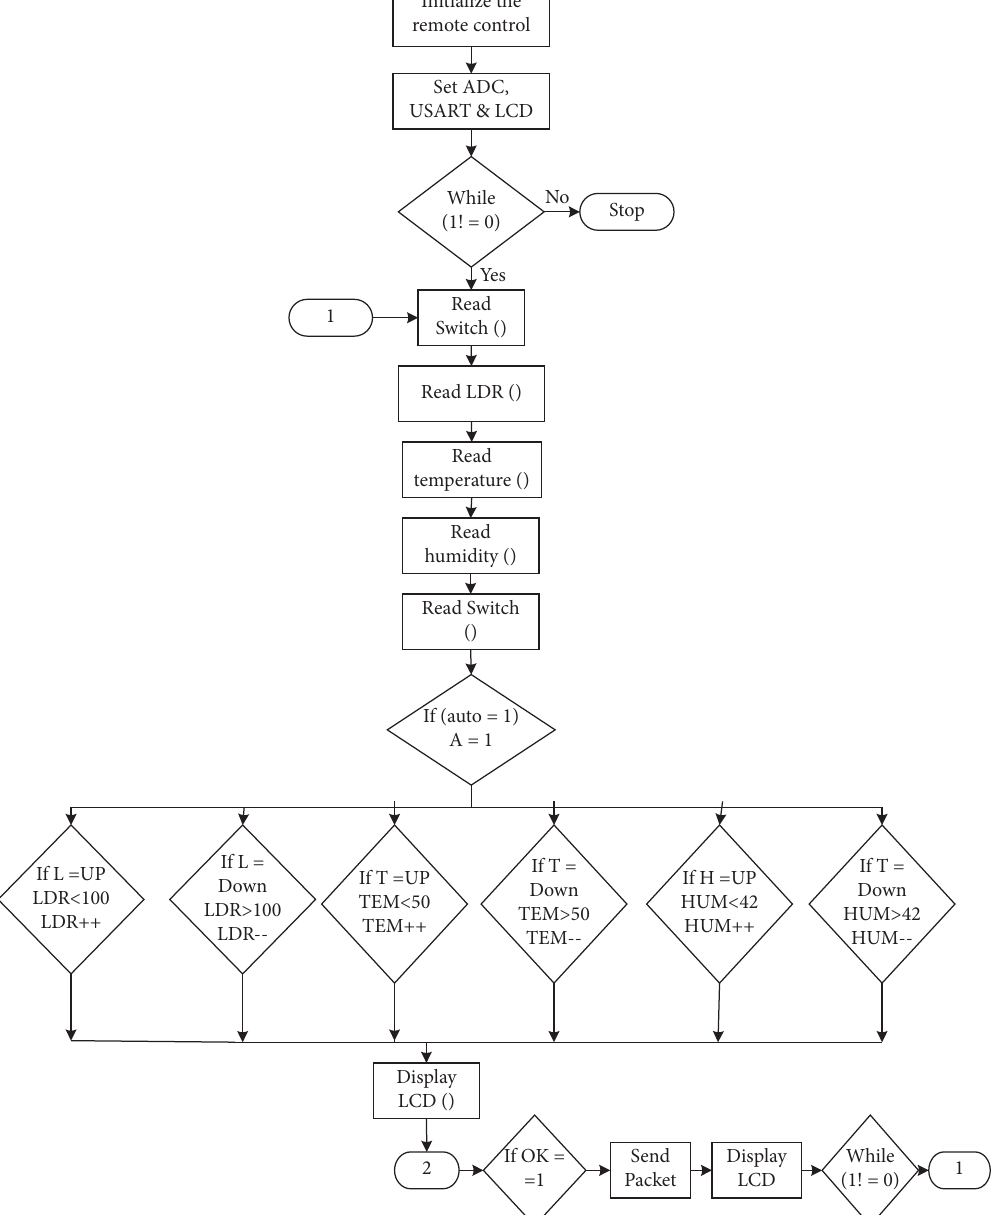
Figure 8: Flowchart for the remote section in autonomous